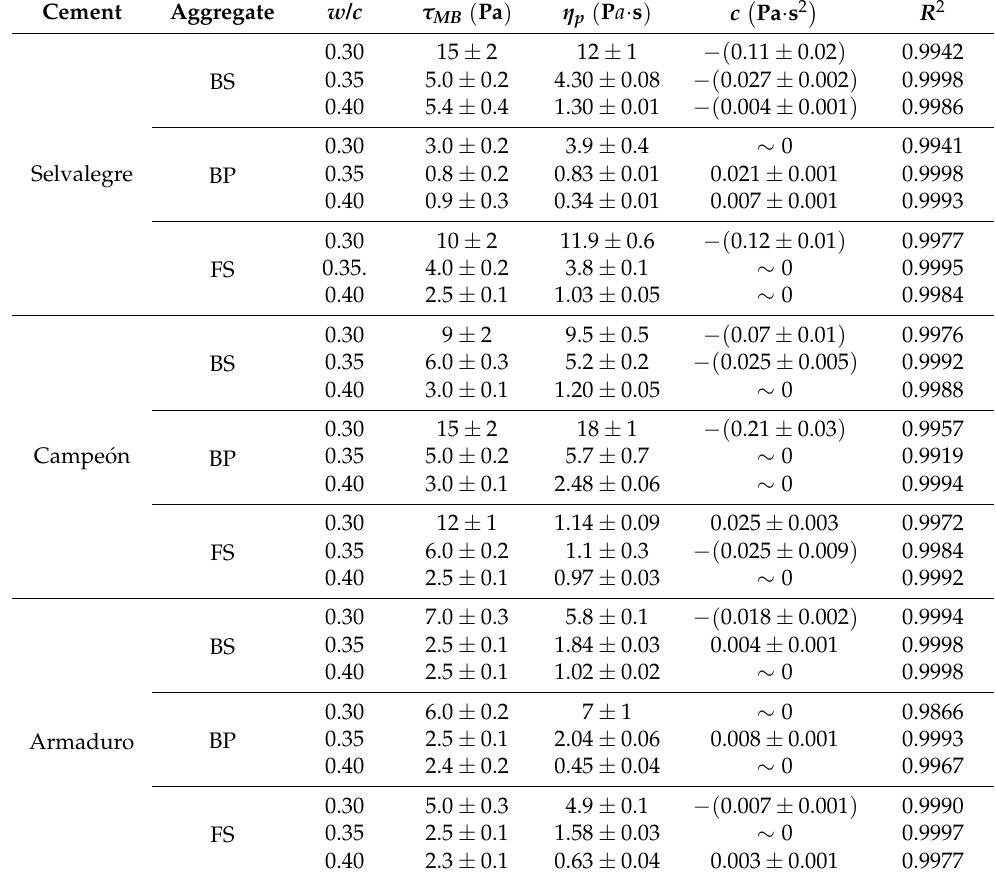
Table 9. Parameters of modified Bingham equation. F2-CEMs.